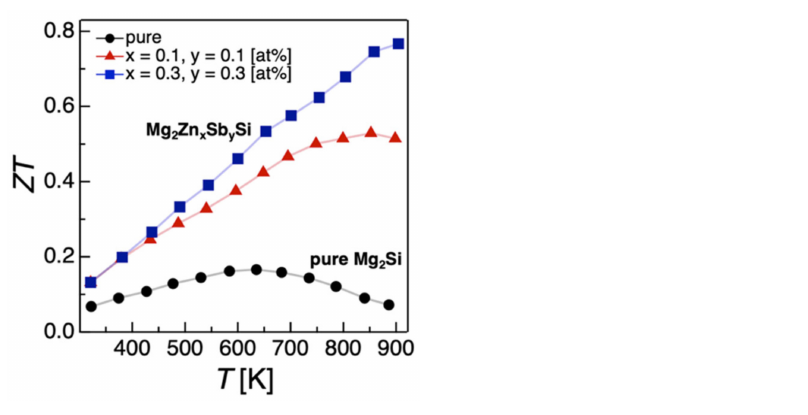
Figure 6. TE performances estimated in terms of the dimensionless figure of merit ZT for the Mg 2 MSi (M = Sb, Zn) specimens. (Reprinted by permission from Springer Nature: Springer, Journal of Electronic Materials , “Enhanced thermoelectric performance of vertical Bridgman-grown Mg 2 Si by codoping with Sb and Zn”, D. Shiojiri, T. Iida, H. Hamba, T. Kodama, M. Yamaguchi, N. Hirayama. and Y. Imai, Copyright